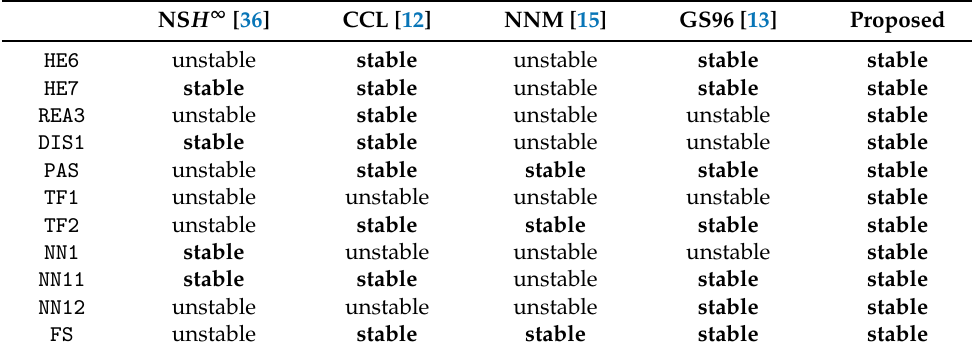
Table 2. Stabilizing static controller results (the full list available at